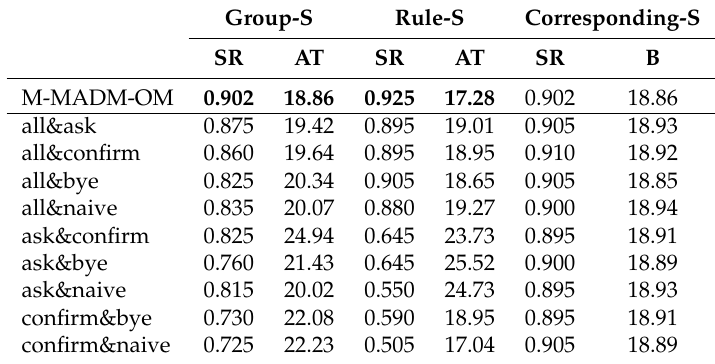
Table 5. The different combinations of seed simulators in one-to-two learning on Success Rate (SR) and Average Turns (AT) (Corresponding-S denotes the corresponding training simulators).